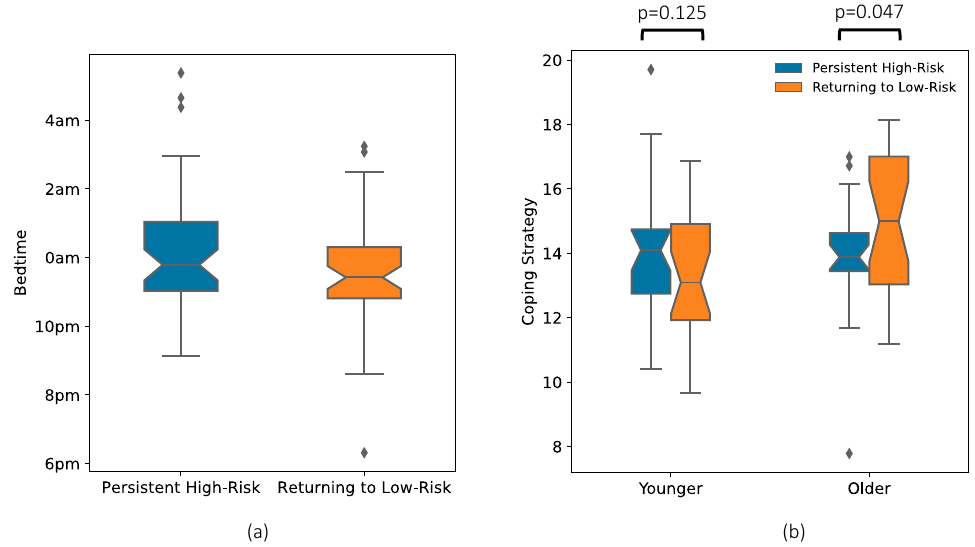
Figure 2. ( a ) Bedtime in June 2020 of the 61 participants returning to the low-risk level was significantly earlier than that of the 58 participants who remained high-risk. ( b ) Older participants returning to low-risk had significantly better coping strategies than the older persistent high-risk group. The same was not true for the younger groups (than the median age at 22.2 years).